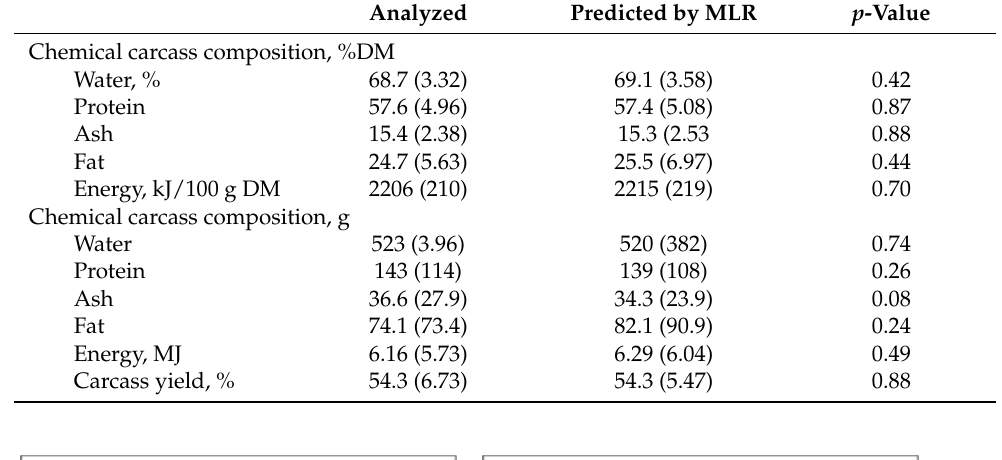
Table 6. Comparison between analyzed and predicted chemical composition (mean (SD)) via multiple linear regression (MLR) using a paired t -test.